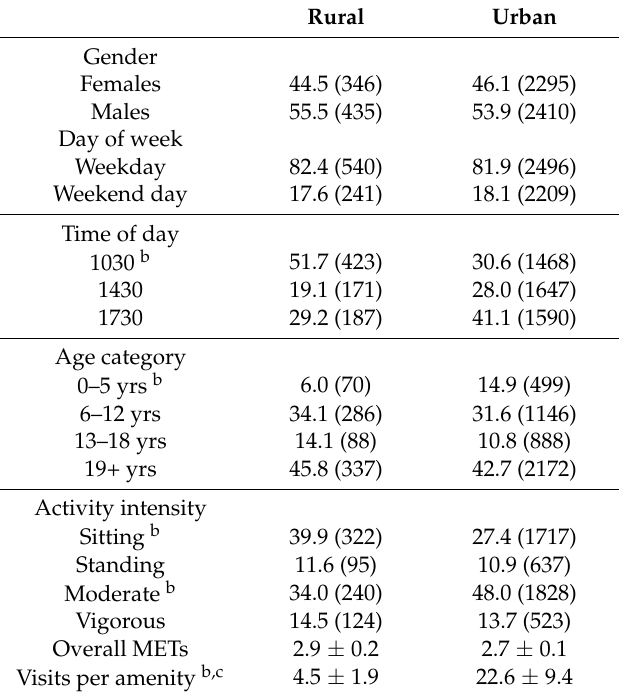
Table 3. Visitation patterns and activity intensity at rural and urban parks a